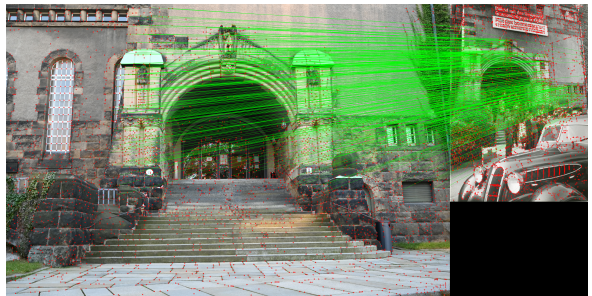
Figure 7. Example for successful feature matching of contemporary and historical image using